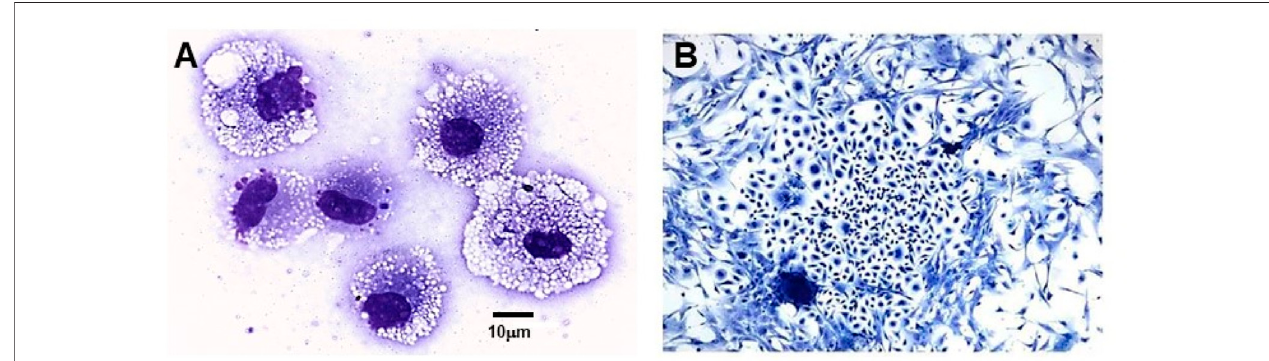
FIGURE 7 | Macrophages and colony-forming cells recruited into a polyvinyl alcohol (PVA) sponge disc containing 10 mg α -gal nanoparticles and implanted for 7 days subcutaneously into anti-Gal – producing GT-KO mice. (A) Large macrophages recruited into the sponge discs. The macrophages are fi lled with vacuoles that contained internalized anti-Gal coated α -gal nanoparticles. (B) Cell colony formed within 5 days of culturing of cell suspension harvested from the sponge discs. The frequency of colony-forming cells among the harvested cells is one in 50,000 – 100,000 cells (Wright staining × 1,000). Adapted from Galili U. The natural anti-Gal antibody as foe turned friend in medicine. Publishers Academic Press/Elsevier, London, 2018, with permission.